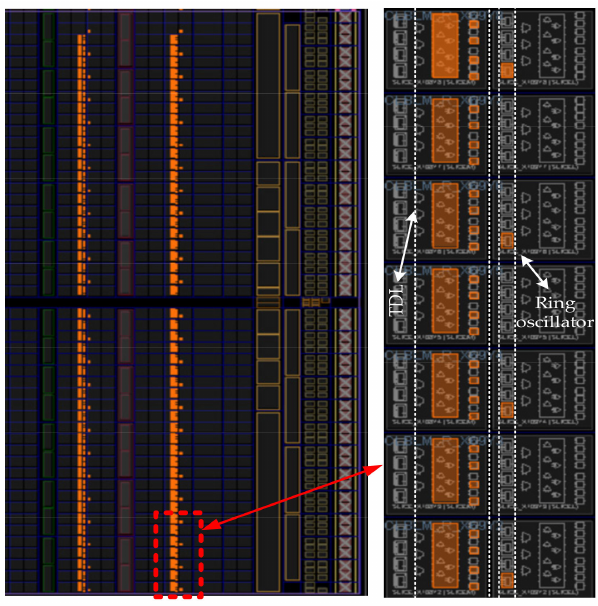
Figure 6. Layout view of the delay line and the ring oscillator in the proposed on-line